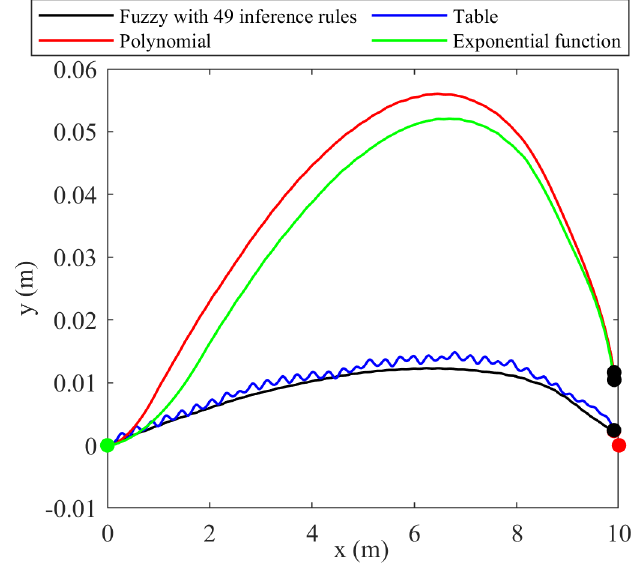
Figure 15. Comparison of the fuzzy control surface approximation methods with simulated model of the mobile robot at the initial angle of deflection δ = 0° and maximum motor speed of 60%.